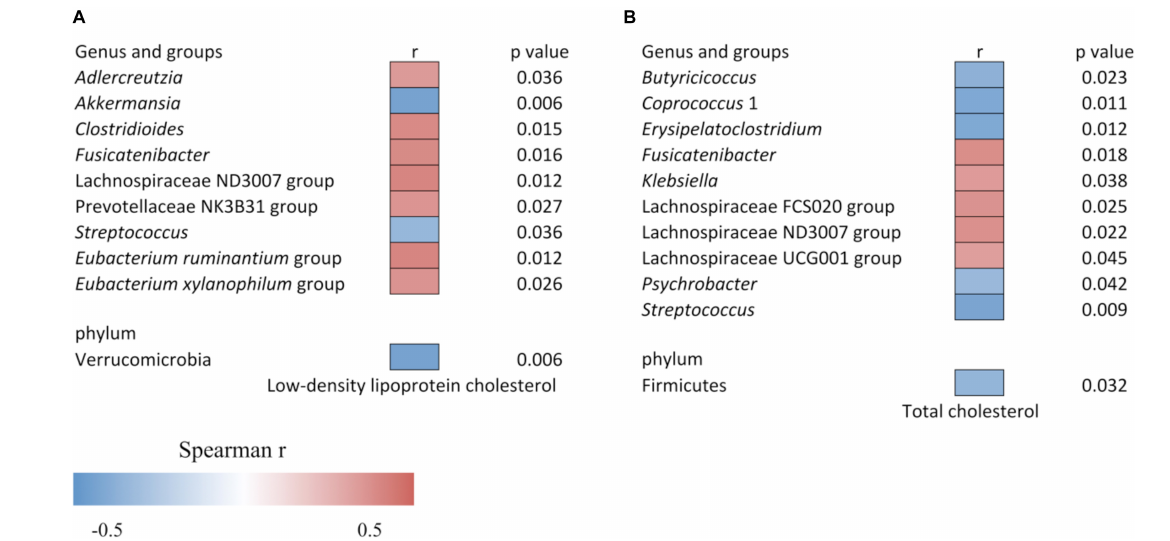
Frontiers in Microbiology |